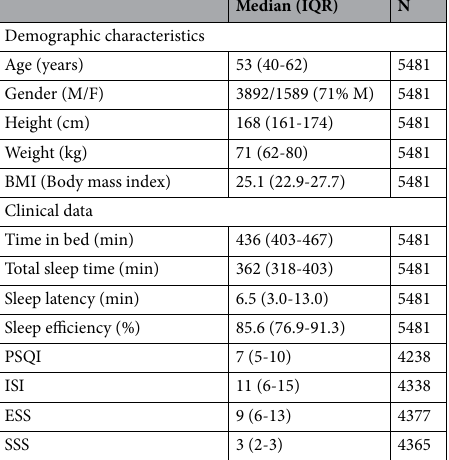
Table 4. Demographic characteristics and clinical